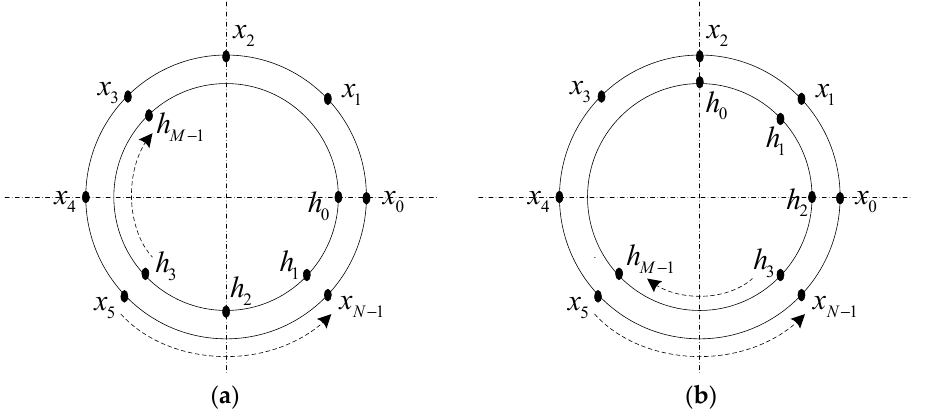
Figure 4. Discrete cyclic convolution calculation. ( a ) Circular offset; ( b ) circular convolution.